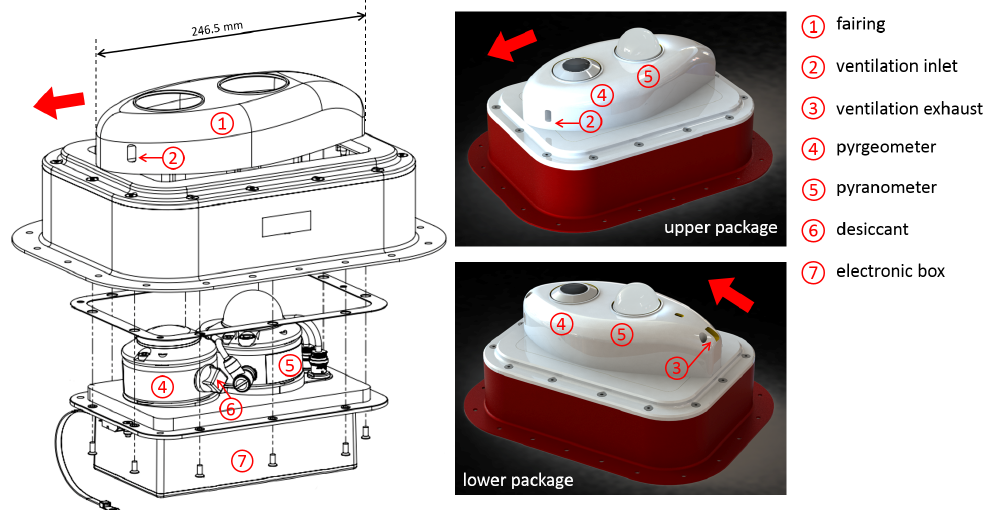
Figure 2. Annotated construction drawing and visualization of the BACARDI sensor packages illustrating the main components: fairing (1) with ventilation inlet (2) and exhaust (3), pyrgeometer (4), pyranometer (5), desiccant cartridge (6), and electronic box (7). The red arrow indicates the flight direction.